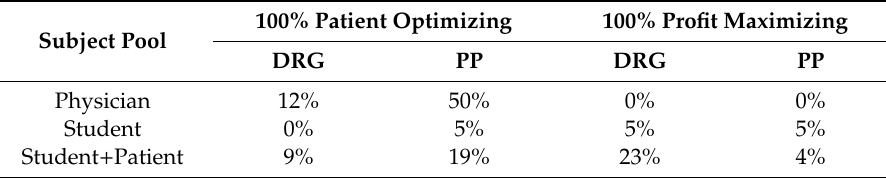
Table A11. Individual treatment types across all subject